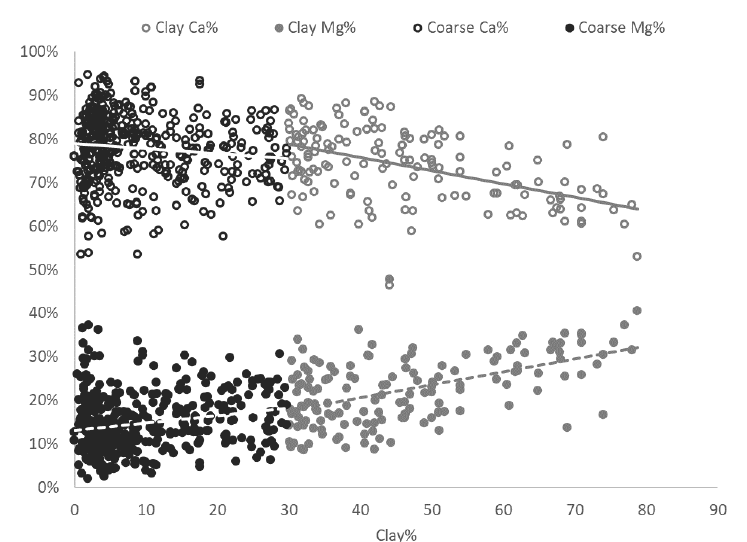
Fig. 7. The share of Ca and Mg of the total soil test cations (STCa, cmol l -1 ; STMg, cmol l -1 ; STK, cmol l -1 ) plotted against clay content in coarse- and medium-textured soils and clay